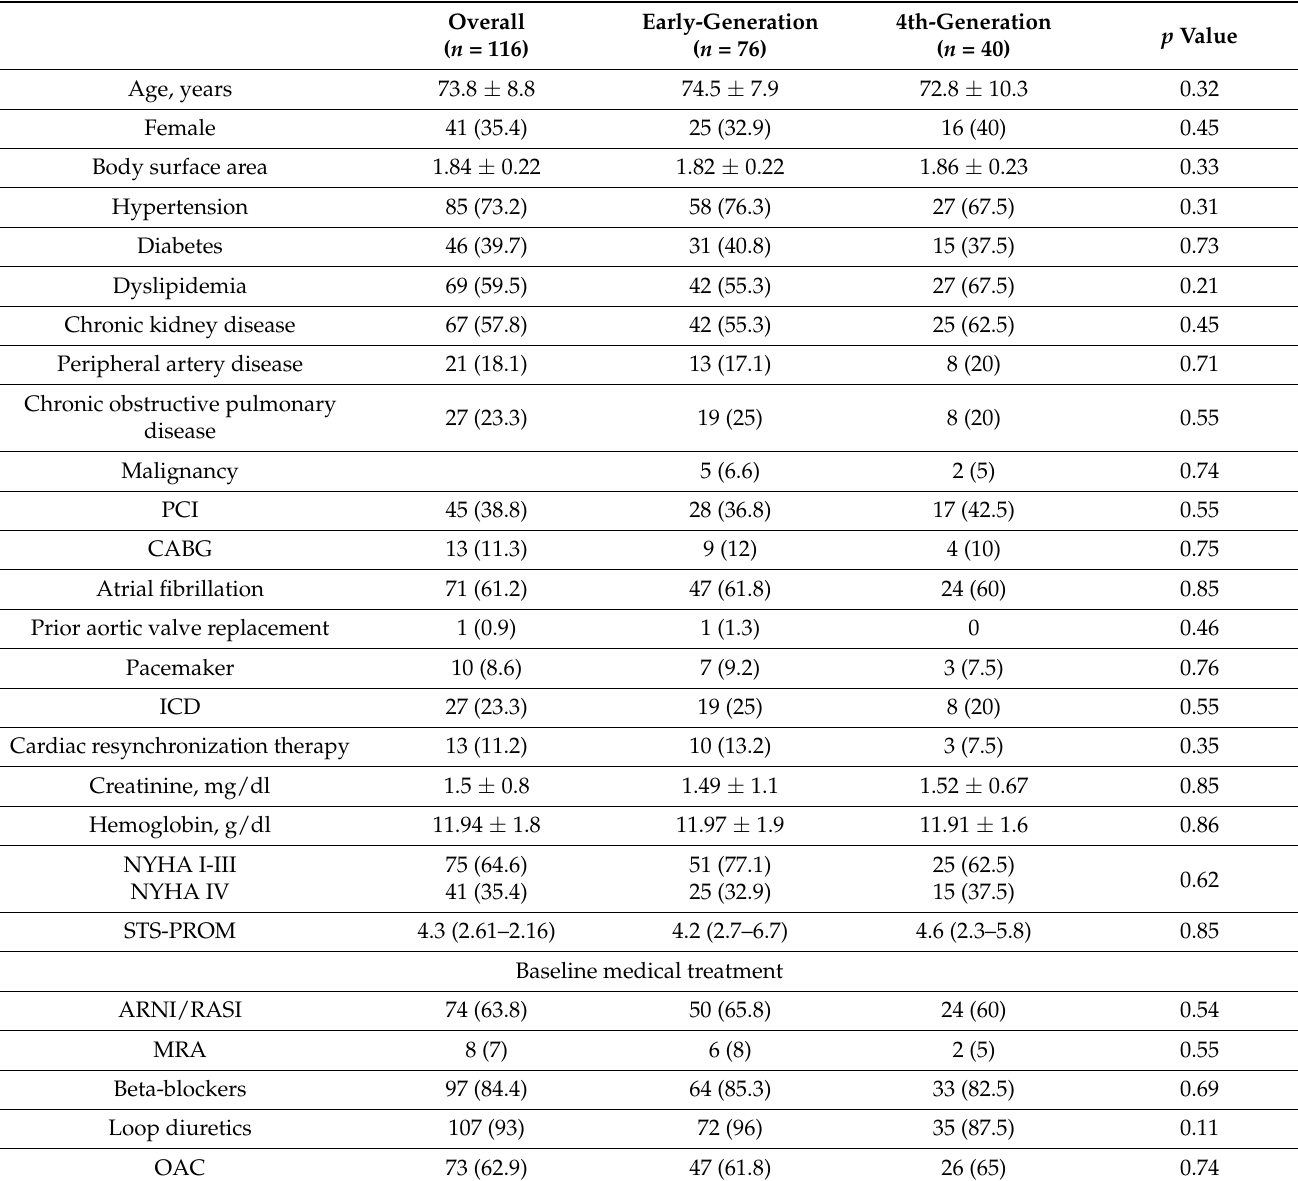
Table 1. Baseline clinical characteristics of patients with functional MR according to the implantation of early-generation vs. 4th-generation MitraClip